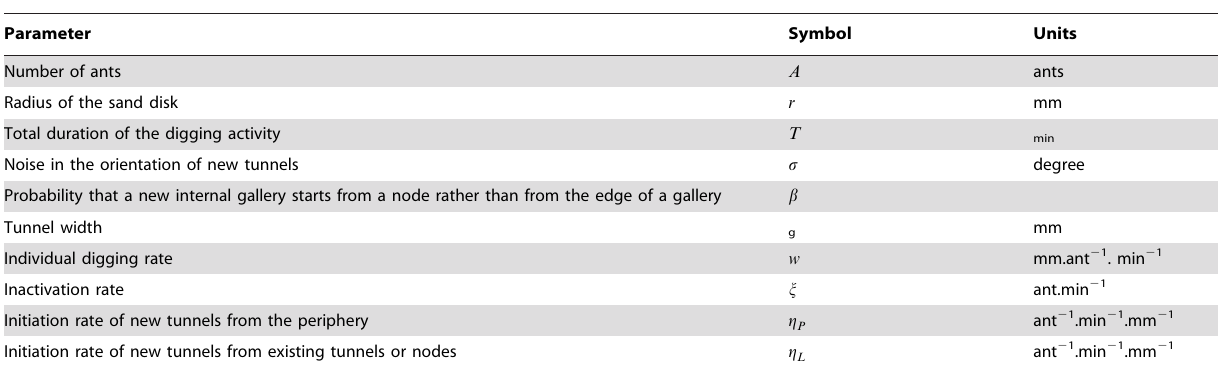
Table 2. Parameters of the